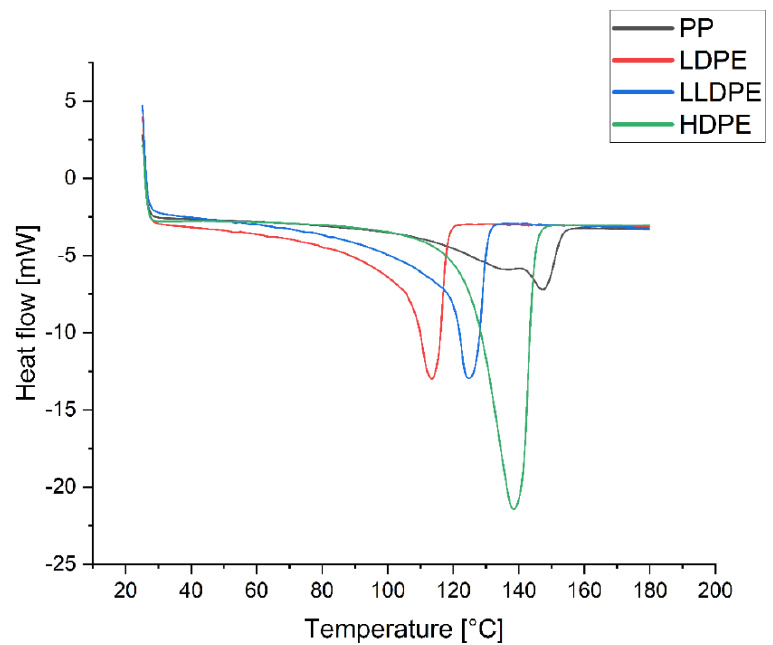
Figure 10. Thermograms of PP, LDPE, LLDPE, and HDPE.